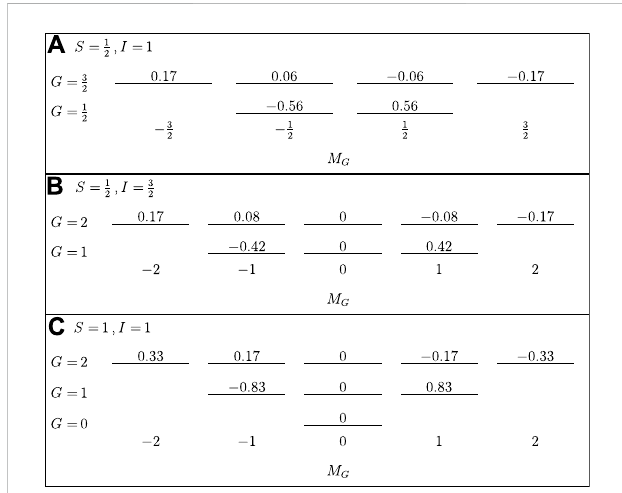
FIGURE 1 Valuesof ζ inhyper fi nestates| G , M G 〉 ,for (A) S =1/2, I =1; (B) S =1/2, I = 3/2; (C) S = 1, I = 1. These are calculated using Eq.